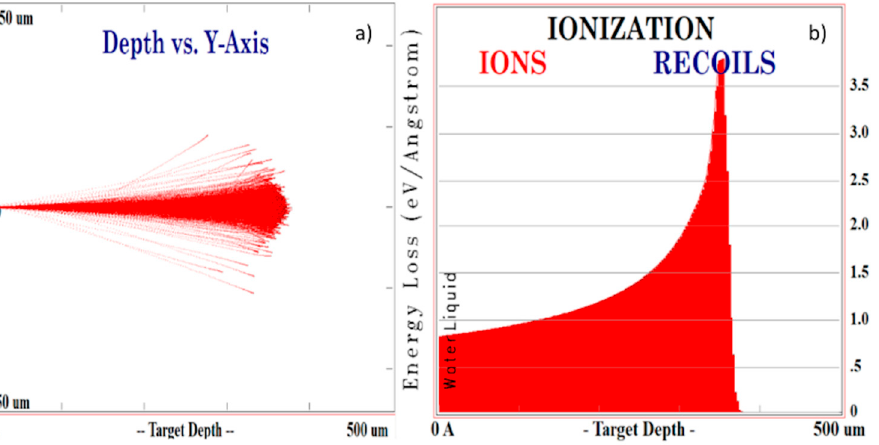
Figure 2. Proton penetration in the water solution ( a ) and stopping power of the protons along the solution depth ( b ).